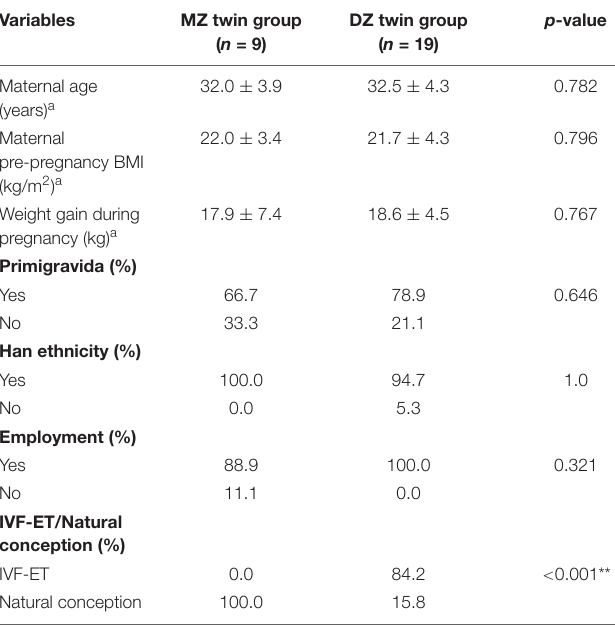
TABLE 1 | Maternal characteristics for the study cohort.